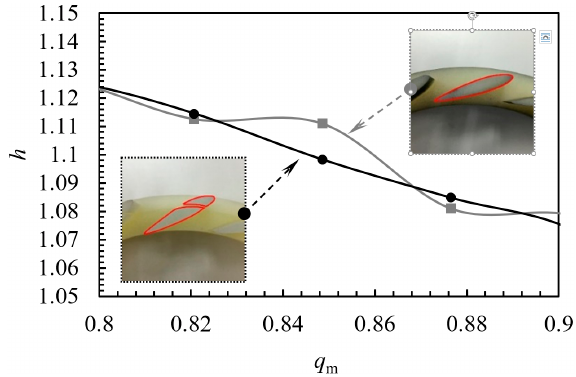
Figure 9. Experimental verification of the “Suppression Method”.